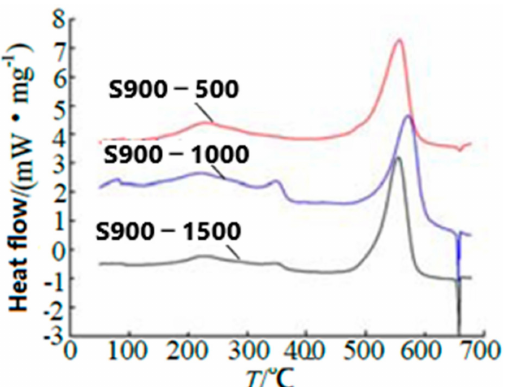
Figure 6. DSC curves of 900 nm thickness MnO 2 samples with nominal 500 nm, 1000 nm, and 1500 nm Al. Reproduced from [34], with permission from Initiators & Pyrotechnics, 2018.